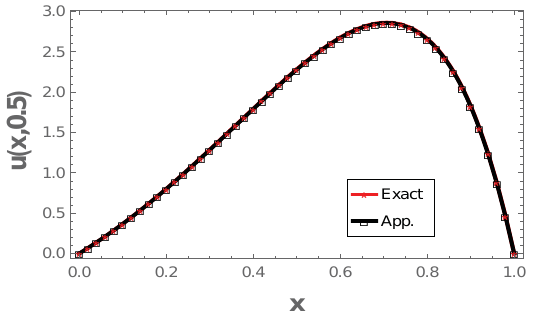
Figure 1: The numerical solutions with the exact solutions at y = 0.5 .